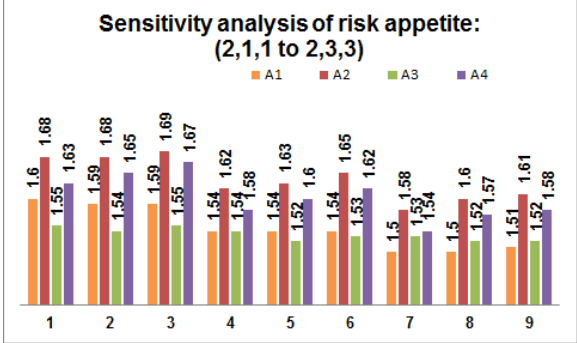
Figure 3. Sensitivity analysis of risk appetite of each DM ((10) 2,1,1 to (18) 2,3,3).